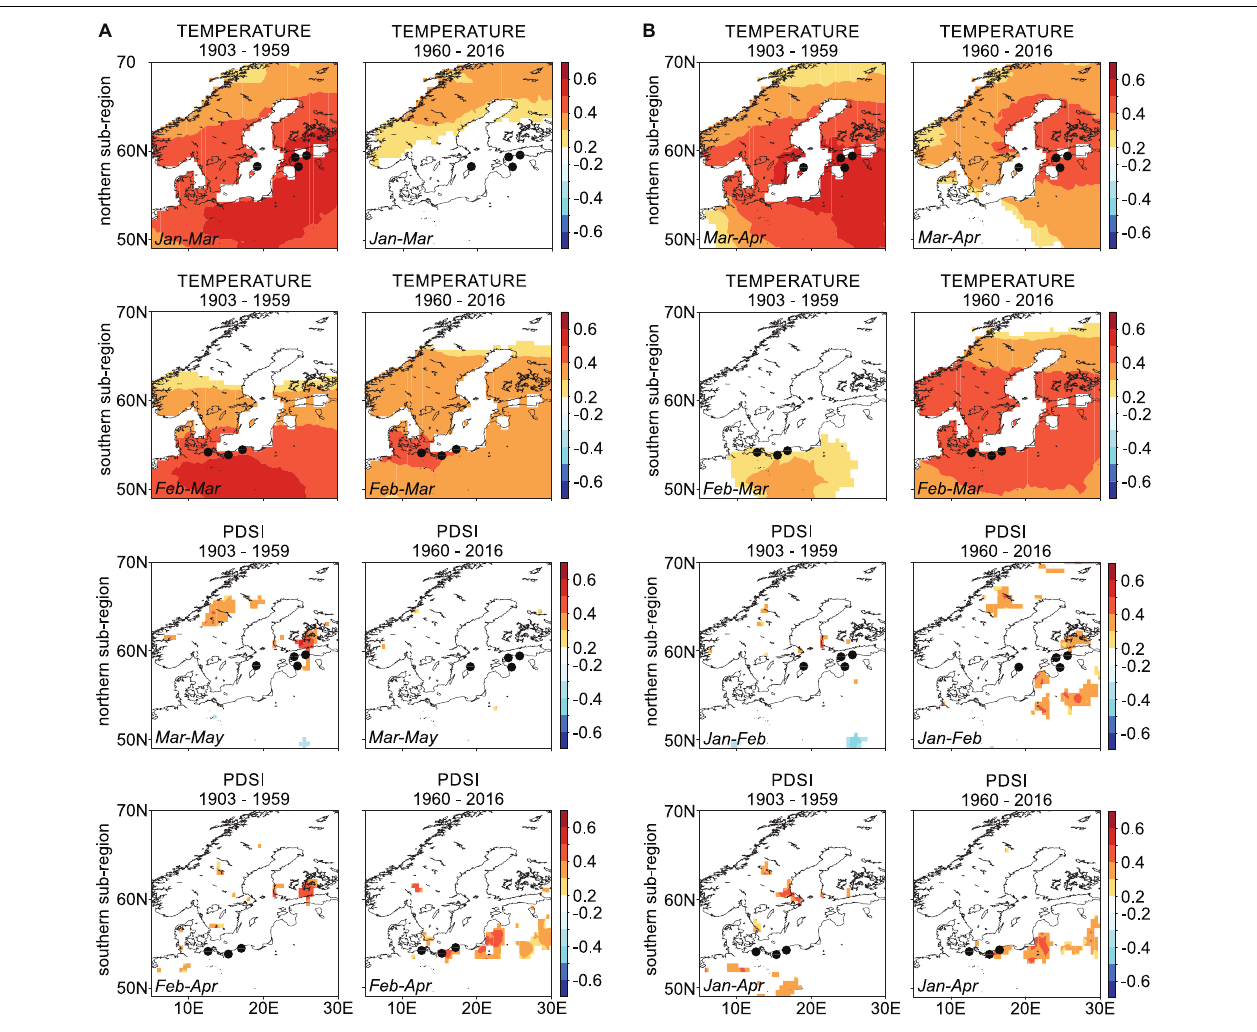
FIGURE 4 | Spatial Pearson correlation maps for northern and southern sub-regions chronologies assessing relationships between (A) ring-width, (B) blue intensity and winter-spring temperature and drought variables (see inset text in each panel for climate season). Dots representing sites GA and GB as well as UA and UB overlap each other due to the small distance between sites (see the detailed location of each site on Figure 1 ). Correlations are based on the 1903–1959 and 1960–2016 intervals. Dots correspond to tree-ring sites shown on Figure 1 and in Table 1 . White color within lands’ borders represent non-significant